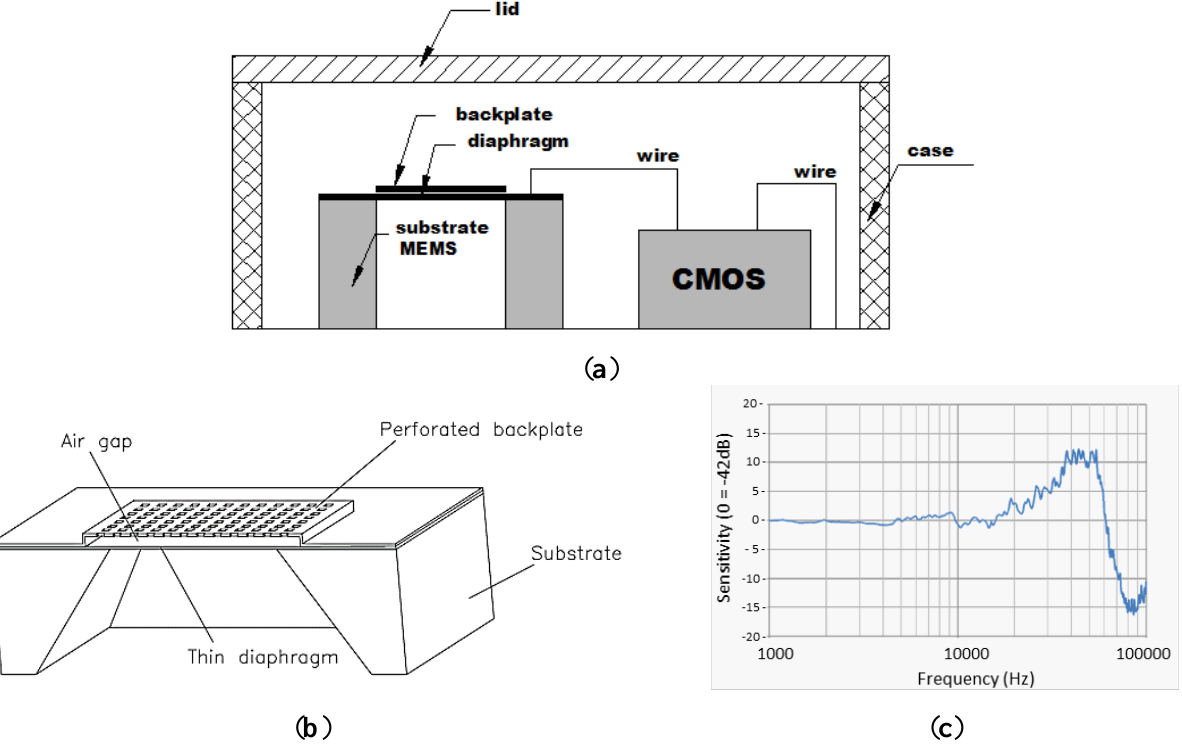
Figure 1. Basic construction ( a ), construction of active elements ( b ) (Reproduced with permission from [10]) and frequency response ( c ) (Reproduced with permission from [11]), of the type of micro-electro-mechanical sensors (MEMS) sensor used in this work: nominal sensitivity = 7.9